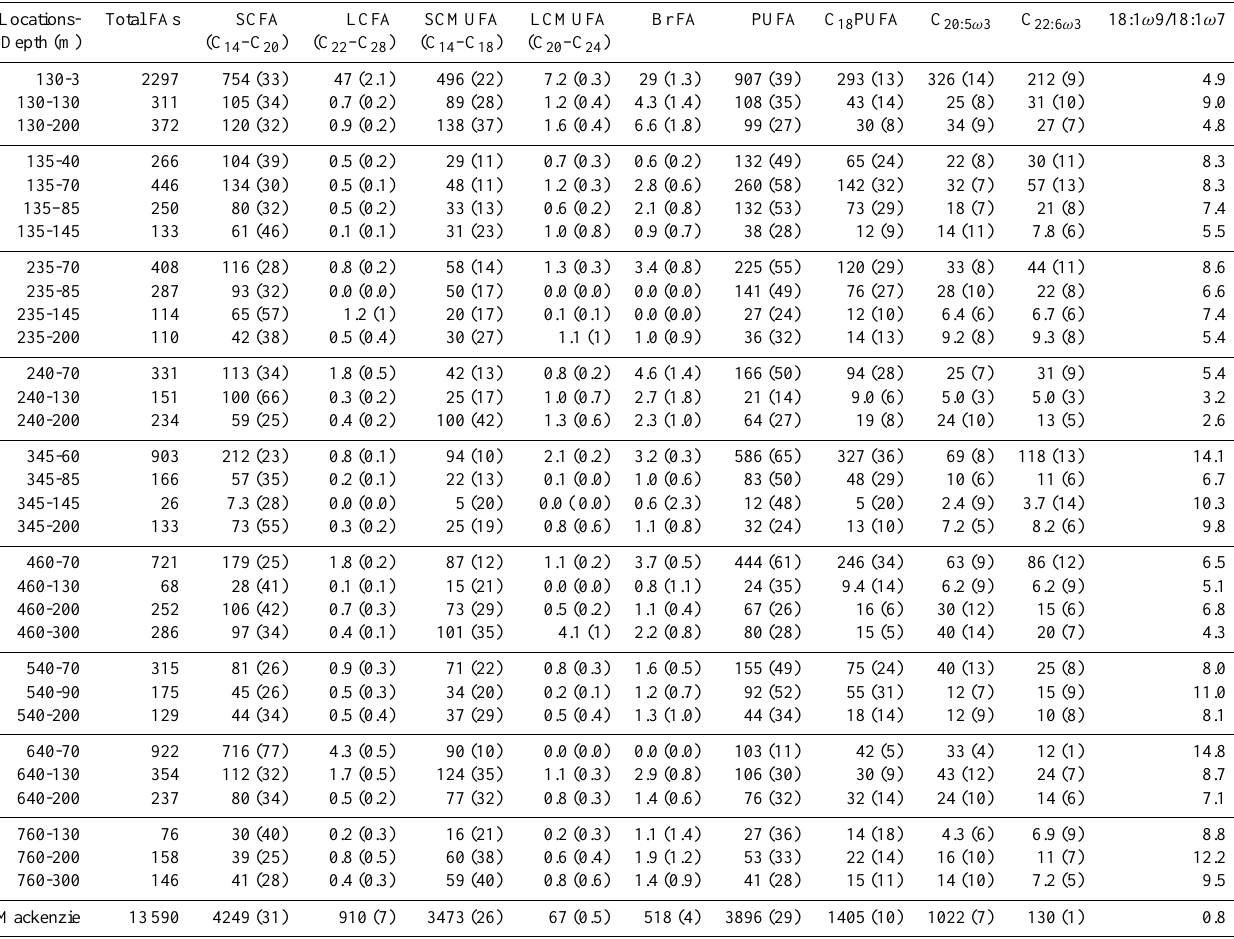
Table 9. Concentrations and diagnostic ratios of selected fatty acids (FAs) in SPM from the Beaufort Sea (ngL − 1 ). Percentage of total FAs is given in brackets.